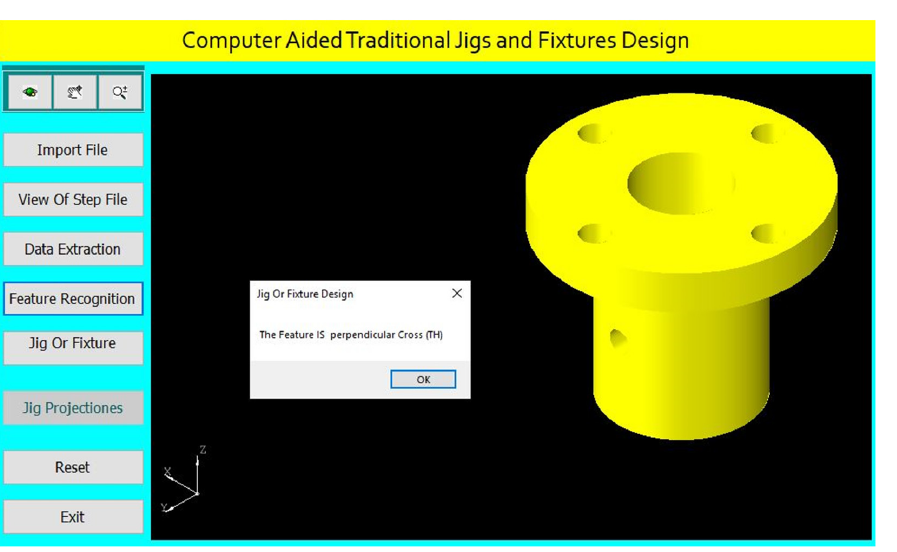
Figure 40. A drawing for the required jig design of the part.